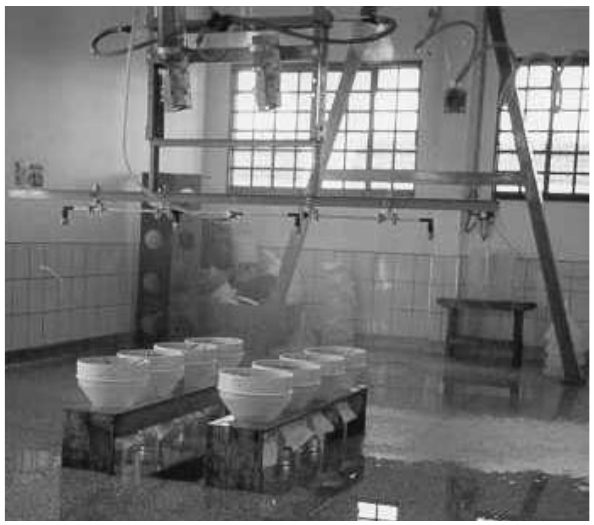
Figura 1. Simulador de chuva utilizado no experi- mento. Em detalhe, a disposição dos